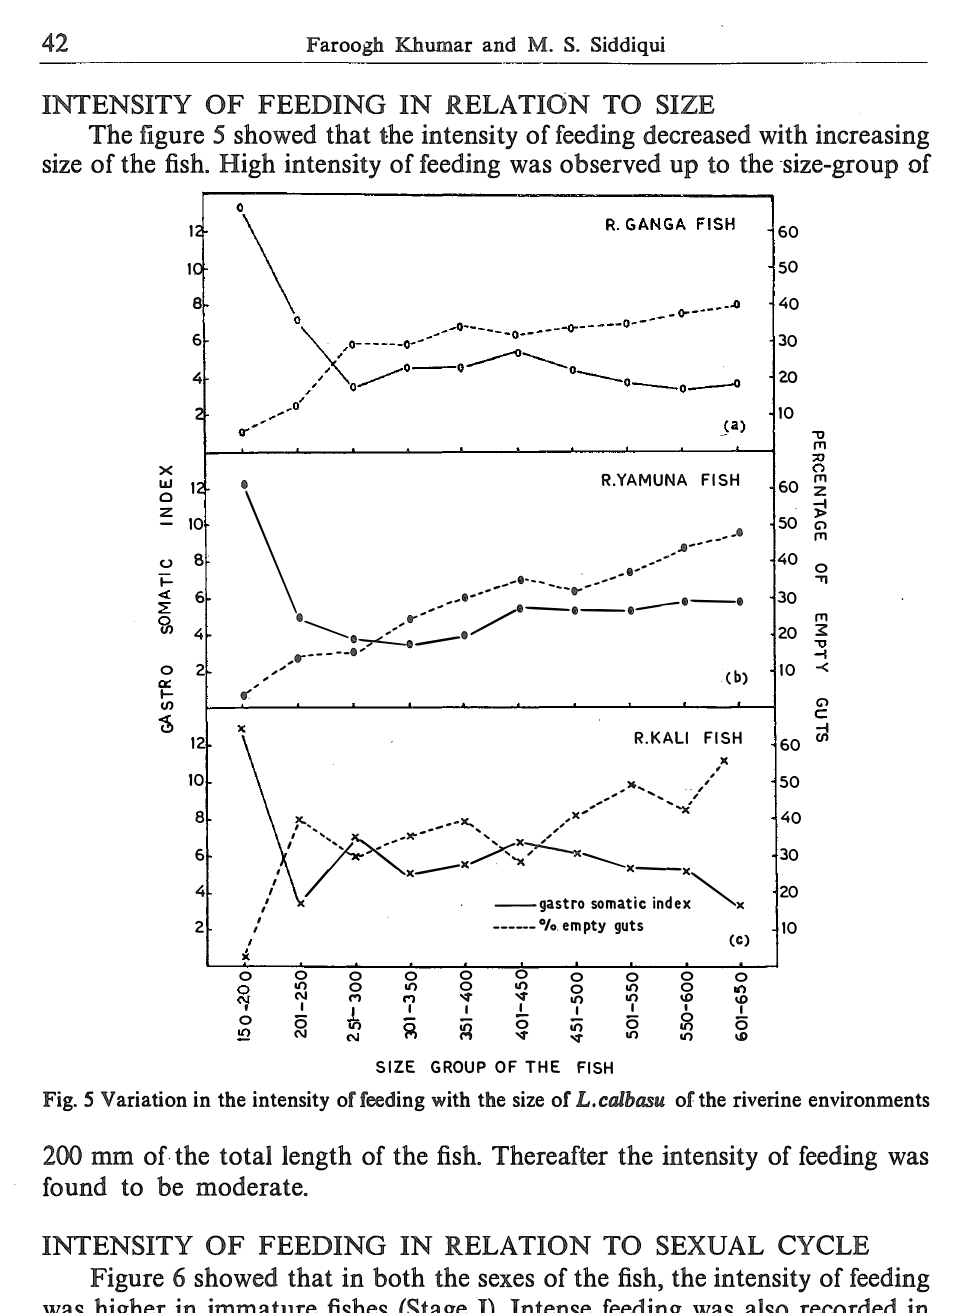
Fig. S Variation in the intensity offeeding with the size of L.calbasu of the riverine environments 200 mm of. the total length of the fish. Thereafter the intensity of feeding was found to be